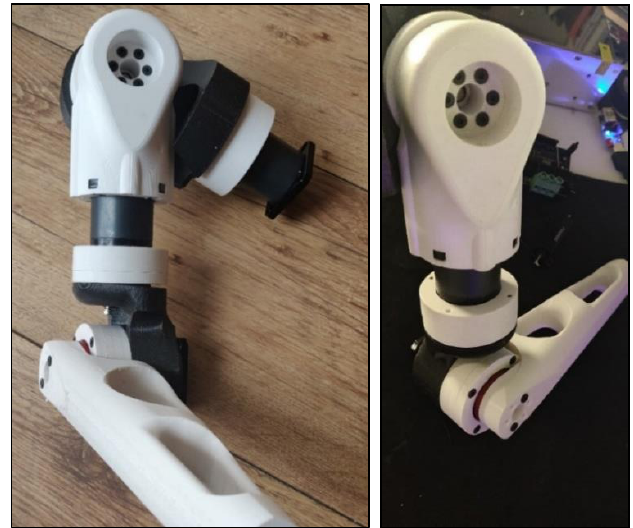
Figure 6. The manufactured and integrated Robotic Arm